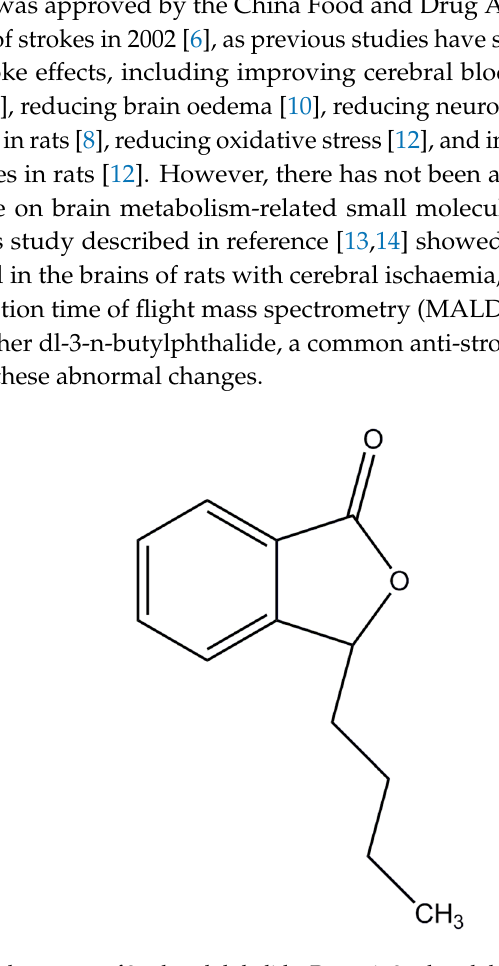
Figure 1. Thechemicalstructureof3-n-butylphthalide. Racemic3-n-butylphthalide, ordl-3-n-butylphthalide, Figure 1. The chemical structure of 3-n-butylphthalide. Racemic 3-n-butylphthalide, or dl-3-n- was used in this butylphthalide, was used in this study.